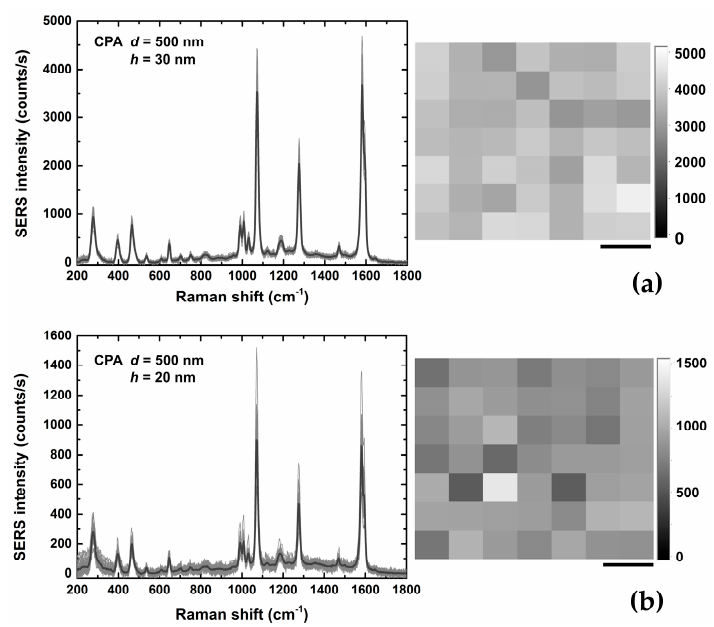
Figure 5. 49 BPT SERS spectra (grey lines) and an intensity map of the band at 1590 cm − 1 for two selected substrates: CPA d = 500 nm, gold thickness h = 30 nm ( a ) and h = 20 nm ( b ). The mean SERS spectrum (black line) is additionally shown. The intra-sample relative standard deviation was respectively about 9–10% for the substrate shown in ( a ) and about 20–22% for the substrate in ( b ). (scale bar = 10 µm).